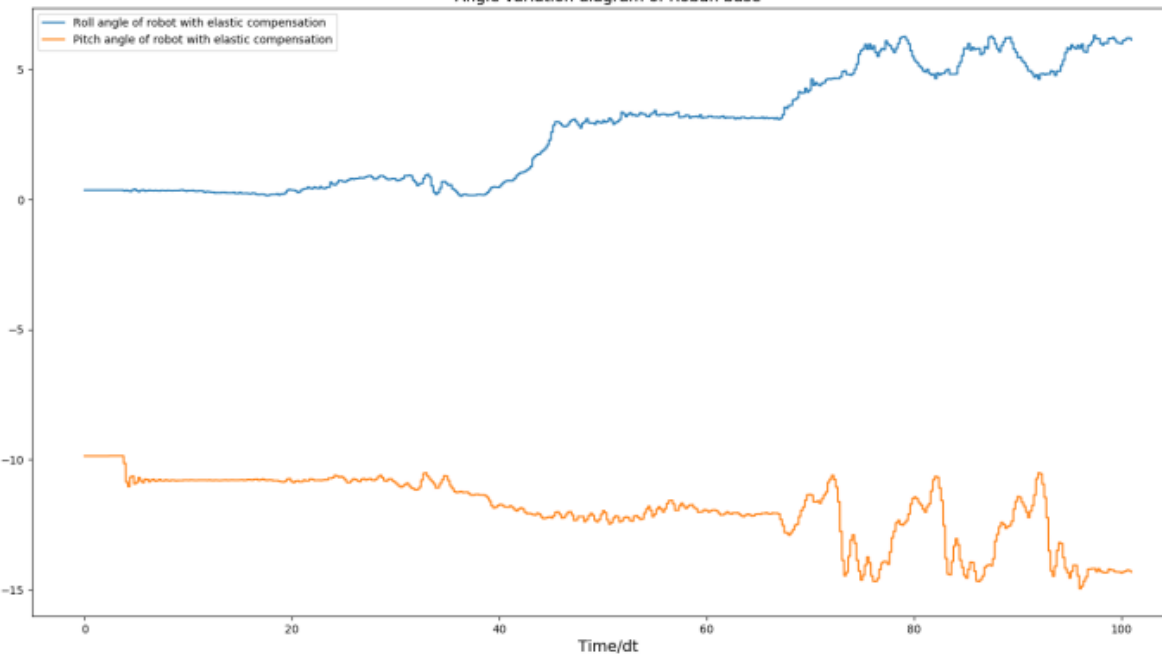
Figure 12. When Roban’s COM moves 5 cm, it completes three squats on a single leg. The changes of roll angle and pitch angle in this process.